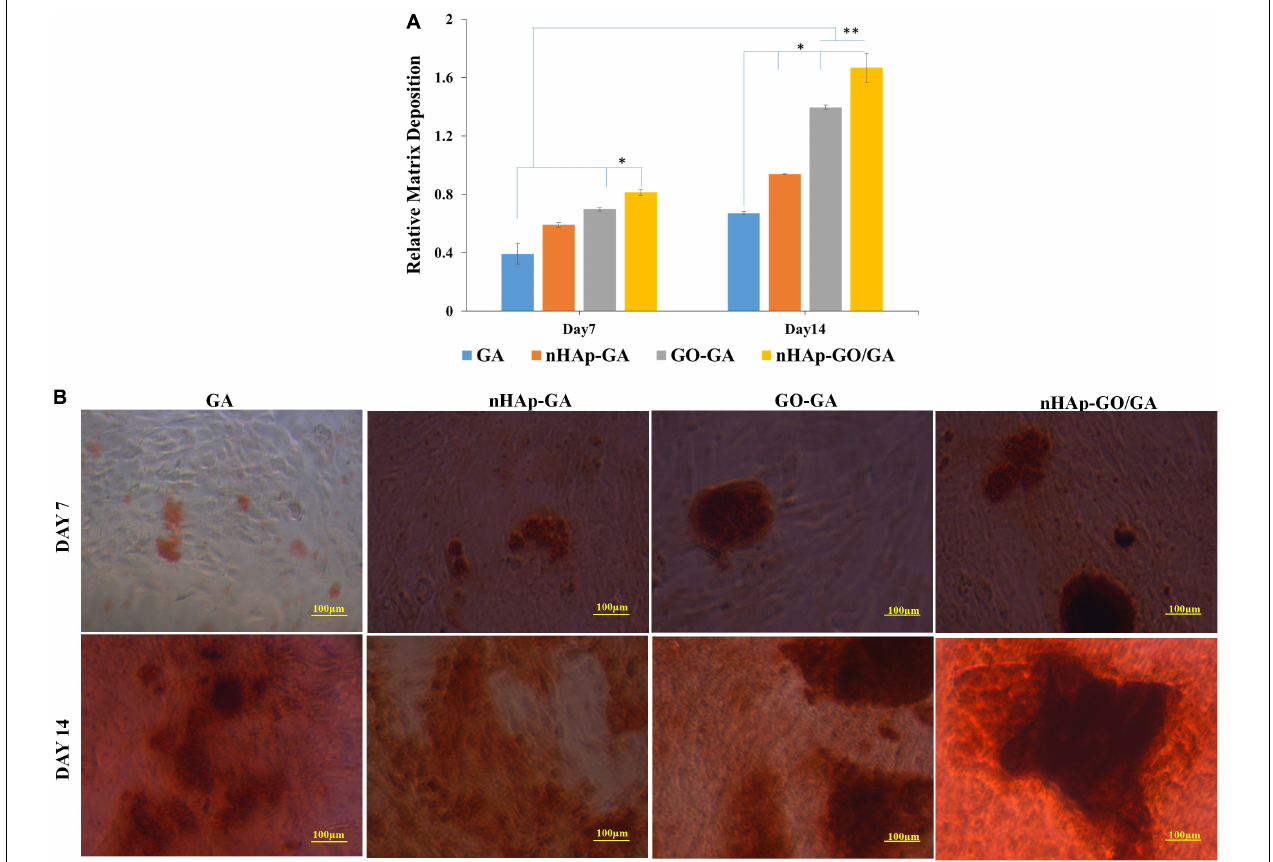
FIGURE 4 | Biological characterization of GA, nHAp-GA, GO-GA, and nHAp-GO/GA nanocomposite scaffolds: Quantitative analysis of absorbed alizarin red S stain (A) , visual depiction of calcium deposition over GA, nHAp-GA, GO-GA, and nHAp-GO/GA nanocomposite scaffolds by alizarin red S staining on day 7 and day 14 (B) . Error bars and columns represent standard deviation and means. ∗∗ p < 0.005 and ∗ p < 0.05 indicate statistical